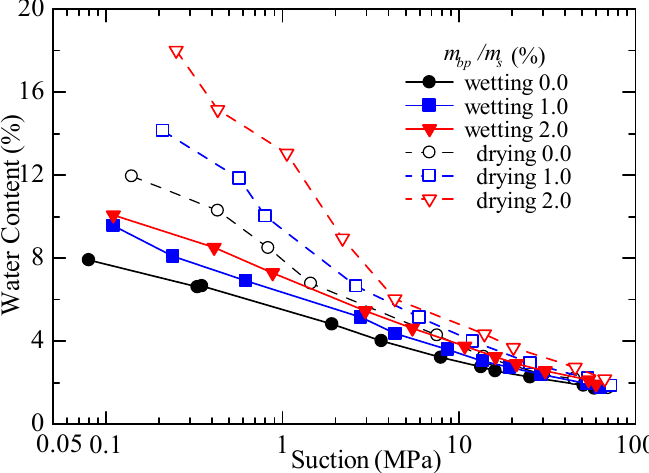
Figure 14. Drying–wetting hysteresis curve of silt with different XG contents.